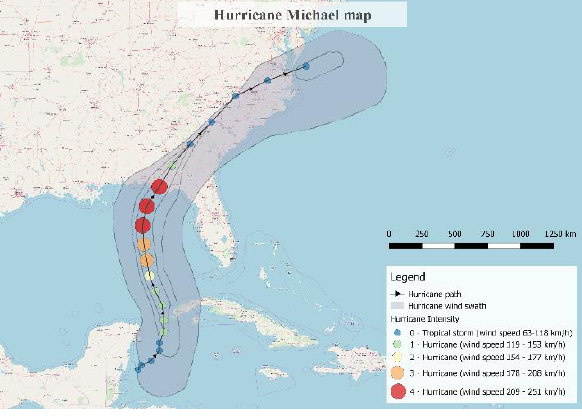
Figure 1. An overview map of the path of Hurricane Michael